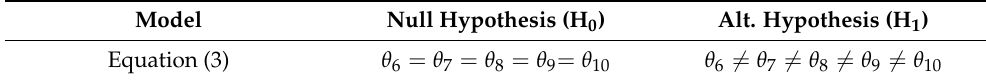
Table 3. Hypothesis for the bound